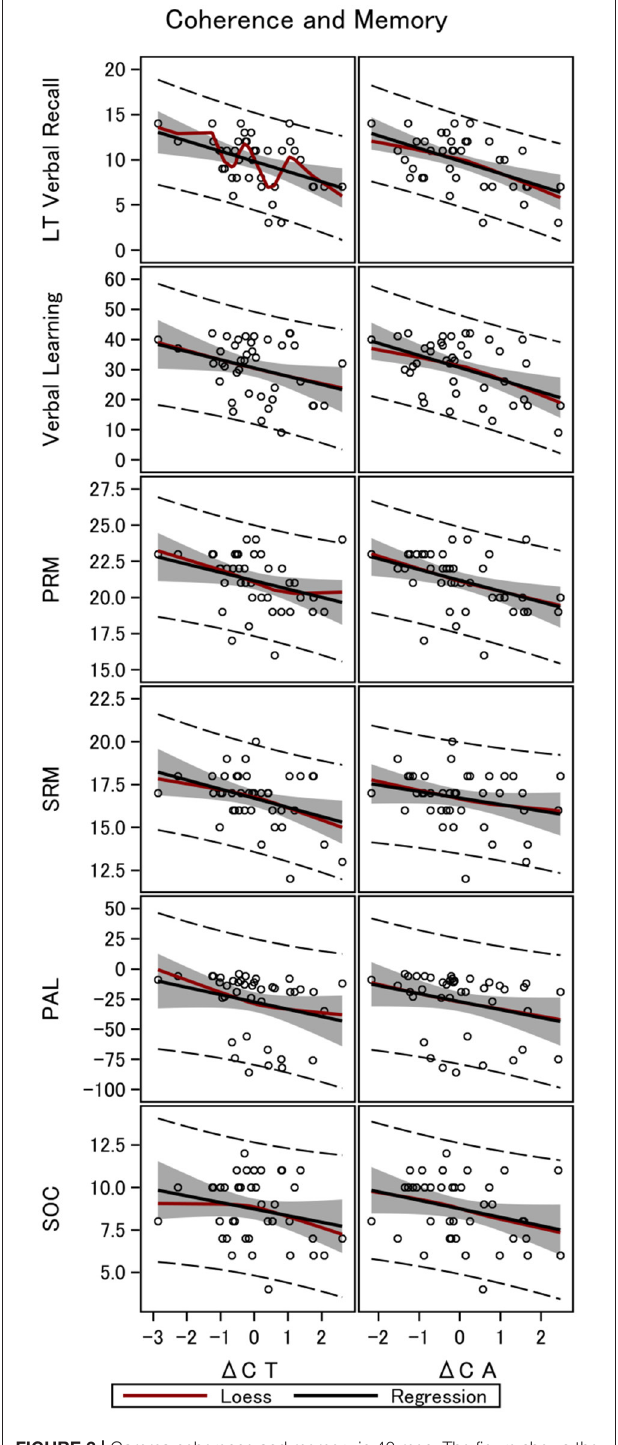
FIGURE 2 | Gamma coherence and memory in 40 men. The figure shows the linear fit between long-term memory and four working memory tests, and the difference in coherence between monomodal and bimodal stimulation. Data are shown for the total brain coherence ( 1 C T ) and coherence in the anterior part of the brain only ( 1 C A ). LT Verbal Recall, Long-Term Verbal Recall Memory; Verbal Learning, Verbal Learning Memory; PRM, Pattern Recognition Memory; SRM, Spatial Recognition Memory; PAL, Paired Associates Learning; SOC, Stockings of